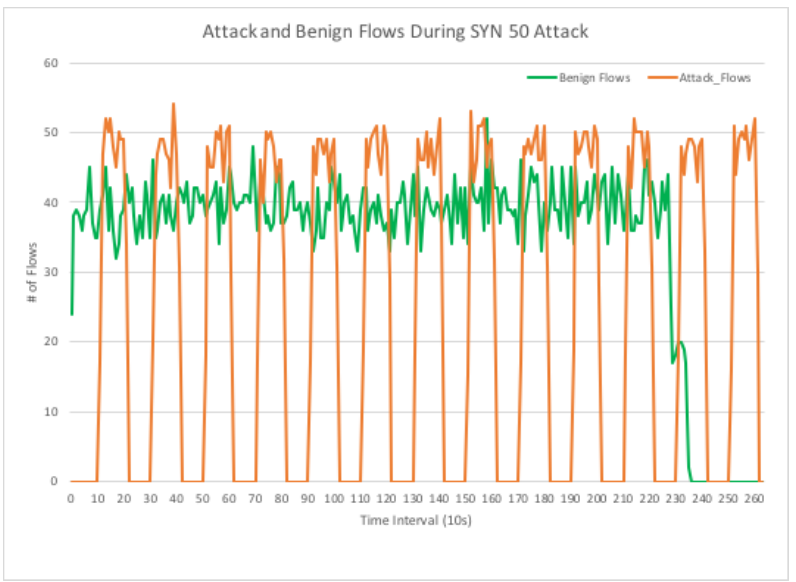
Figure 1. The impact of a pulse-shaped SYN flooding attack with an average rate of 2.5 rps (and peak rate of 50 rps) on benign traffic. The x-axis is marked by 10-s intervals, and the y-axis represents number of new benign and attack flows in each